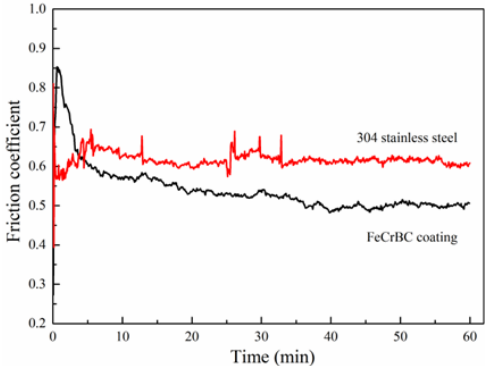
Figure 3. The friction coefficient of the Fe-Cr-B-C coating and substrate.